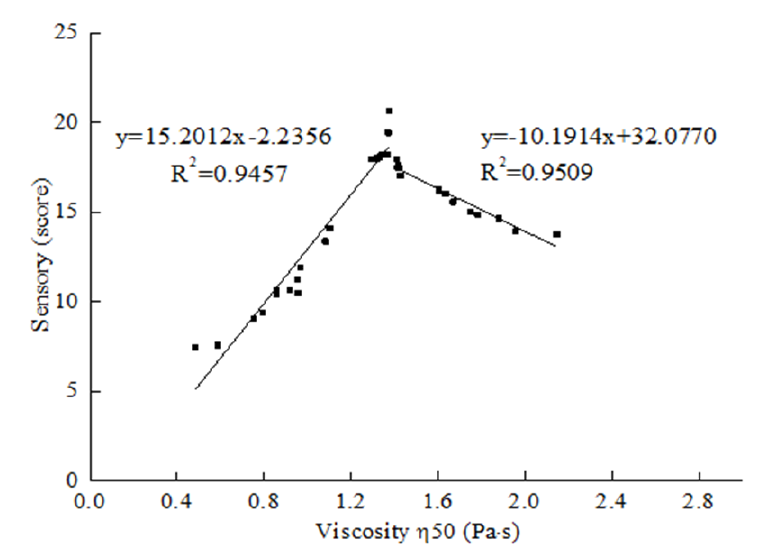
Figure 4. Relationship between sensory evaluation and viscosity 50 (Pa · s). Sensory score was the sum of appearance, texture, and overall acceptability score (Table A3).